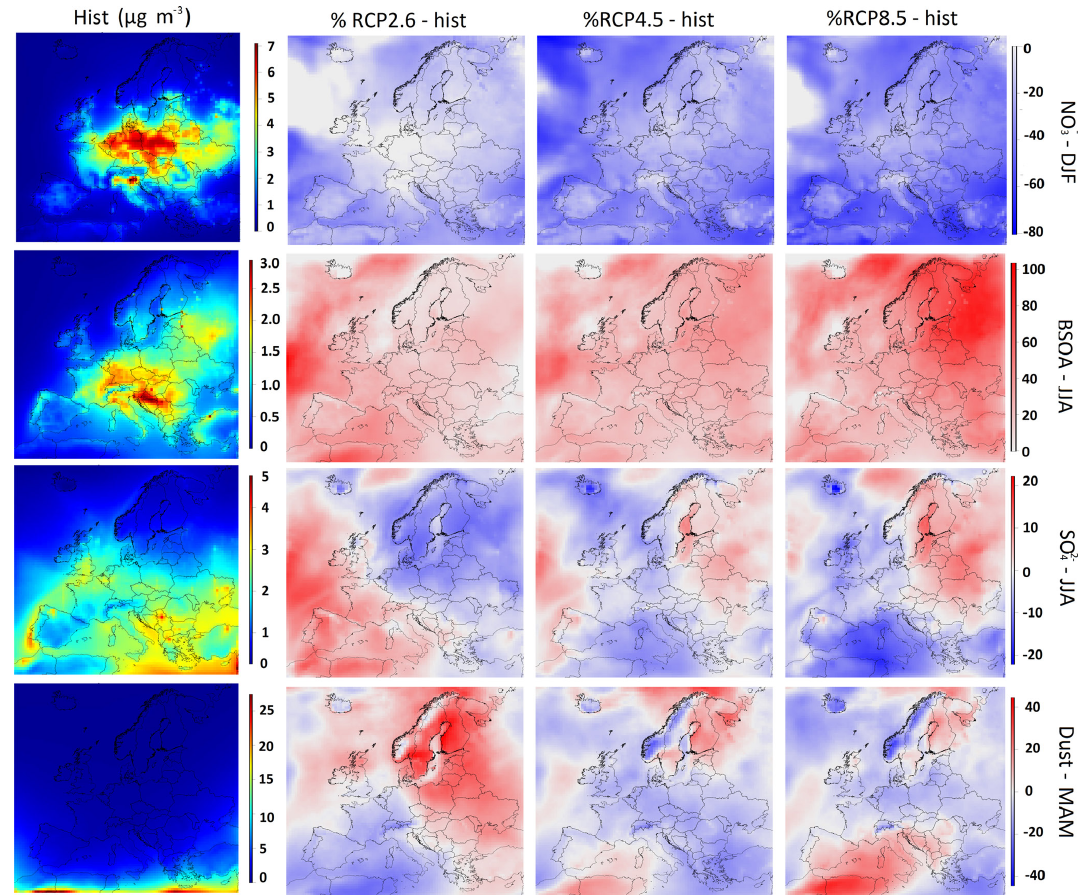
Figure 9. Historic concentrations and relative changes in future scenarios for biogenic SOA (BSOA), nitrates (NO − dust particles for selected seasons in which the concentrations were the highest. Figures in the left column show the average concentration of historic simulations, the other three columns show the relative difference of RCP2.6, RCP4.5 and RCP8.5 future scenarios, respectively, to the historic simulations. Each row shows one season, and the scales are different for each row of